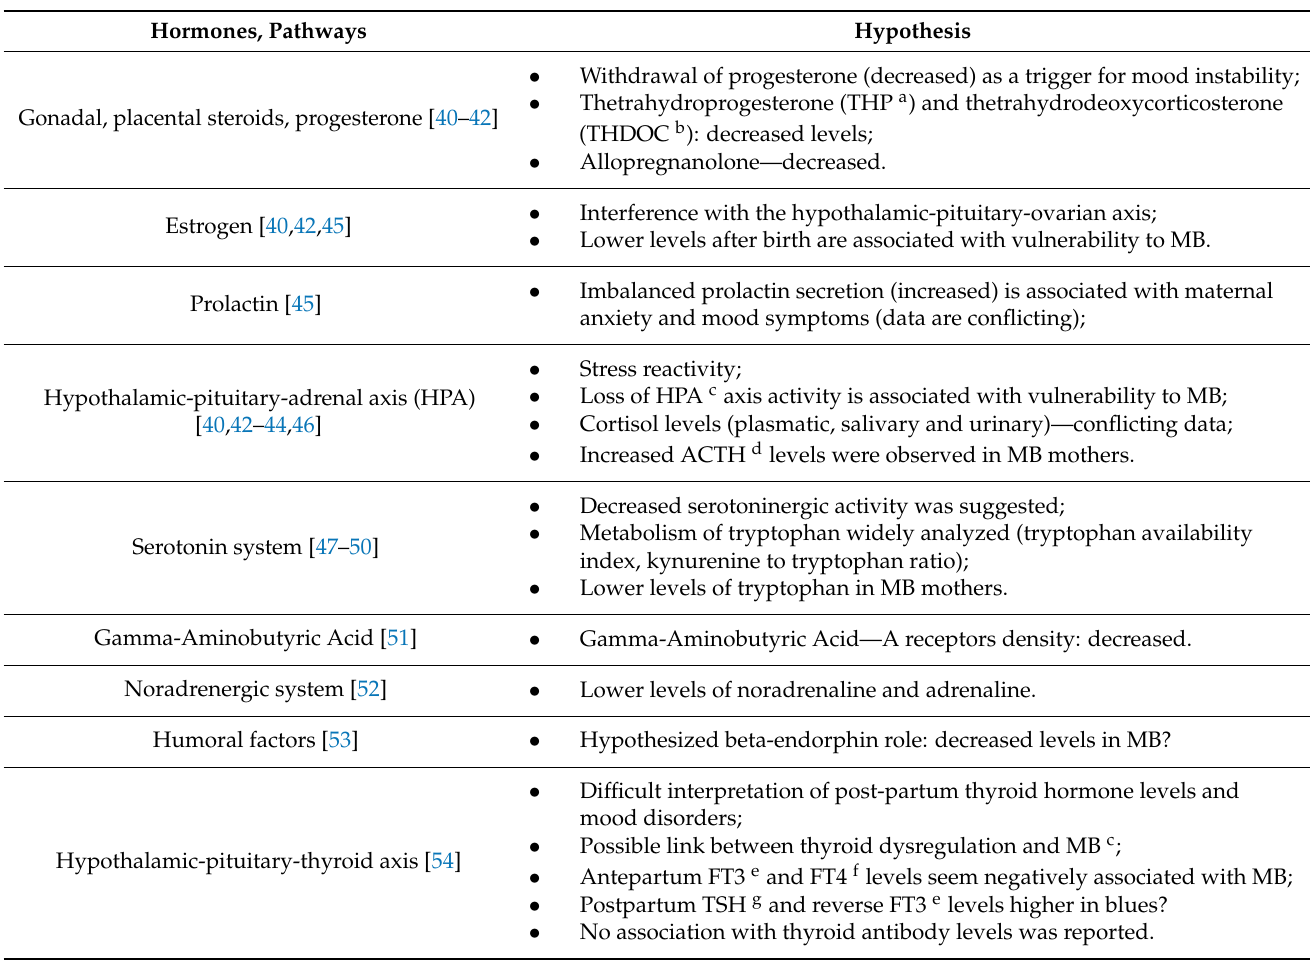
Table 2. Neurobiology-pathophysiology of